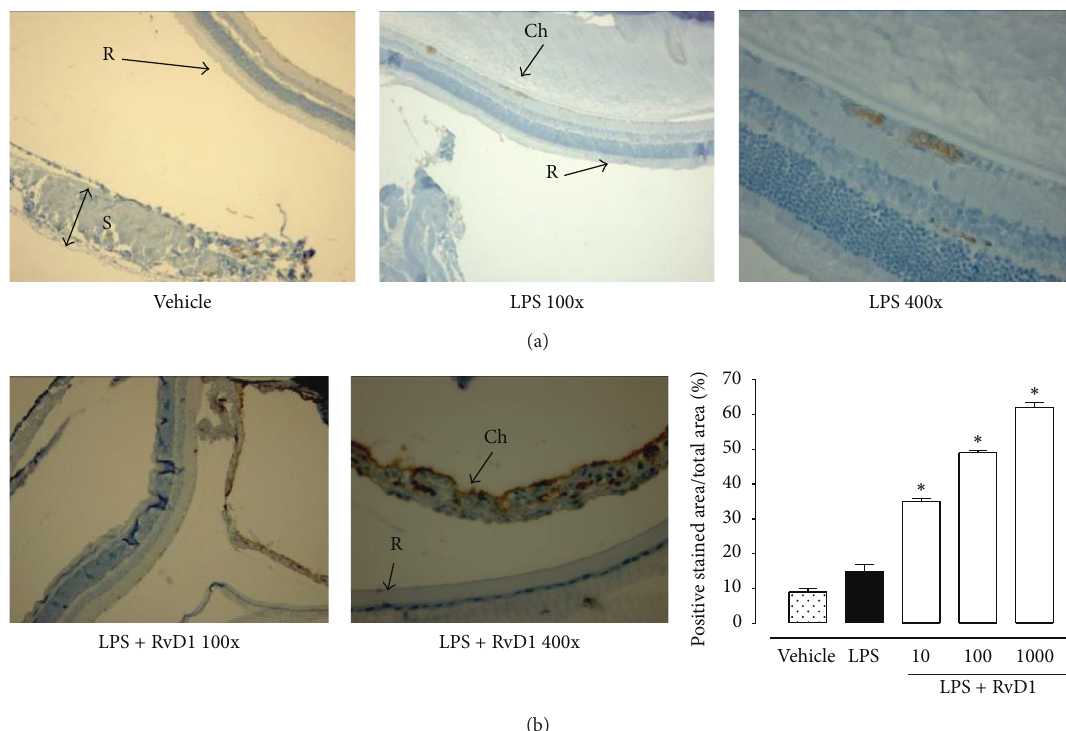
Figure 9: Resolvin D1 (RvD1) treatment induces M2 expression macrophage phenotypes. (a) Representative immunohistochemistry of eye tissues showing that treatment with resolvin D1 (RvD1, 10ng/kg 1h post-LPS) increased immunostaining for M2 macrophage phenotype expression an anti-mannose receptor antibody CD206. (b) Graph showing the percentage of positive stained area per total area analyzed at 400x magnification. Values are mean ± SEM of 𝑛 = 6 observations for group. ∗ 𝑃 < 0.05 and ∗∗ 𝑃 < 0.01 versus LPS-treated group. R = retina; S = sclera Cb = ciliary bodies; Ch =